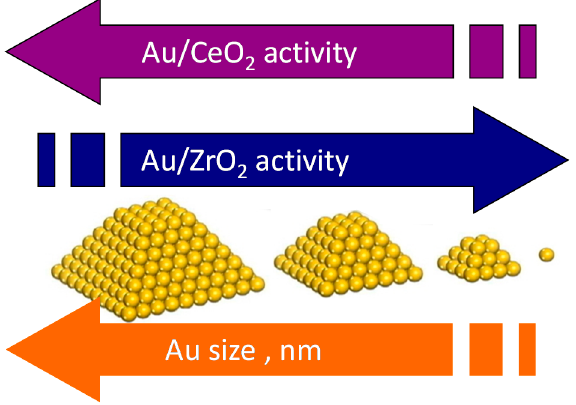
Figure 6. Dependence of the catalytic activity of Au/CeO 2 and Au/ZrO 2 catalysts on the Au size.